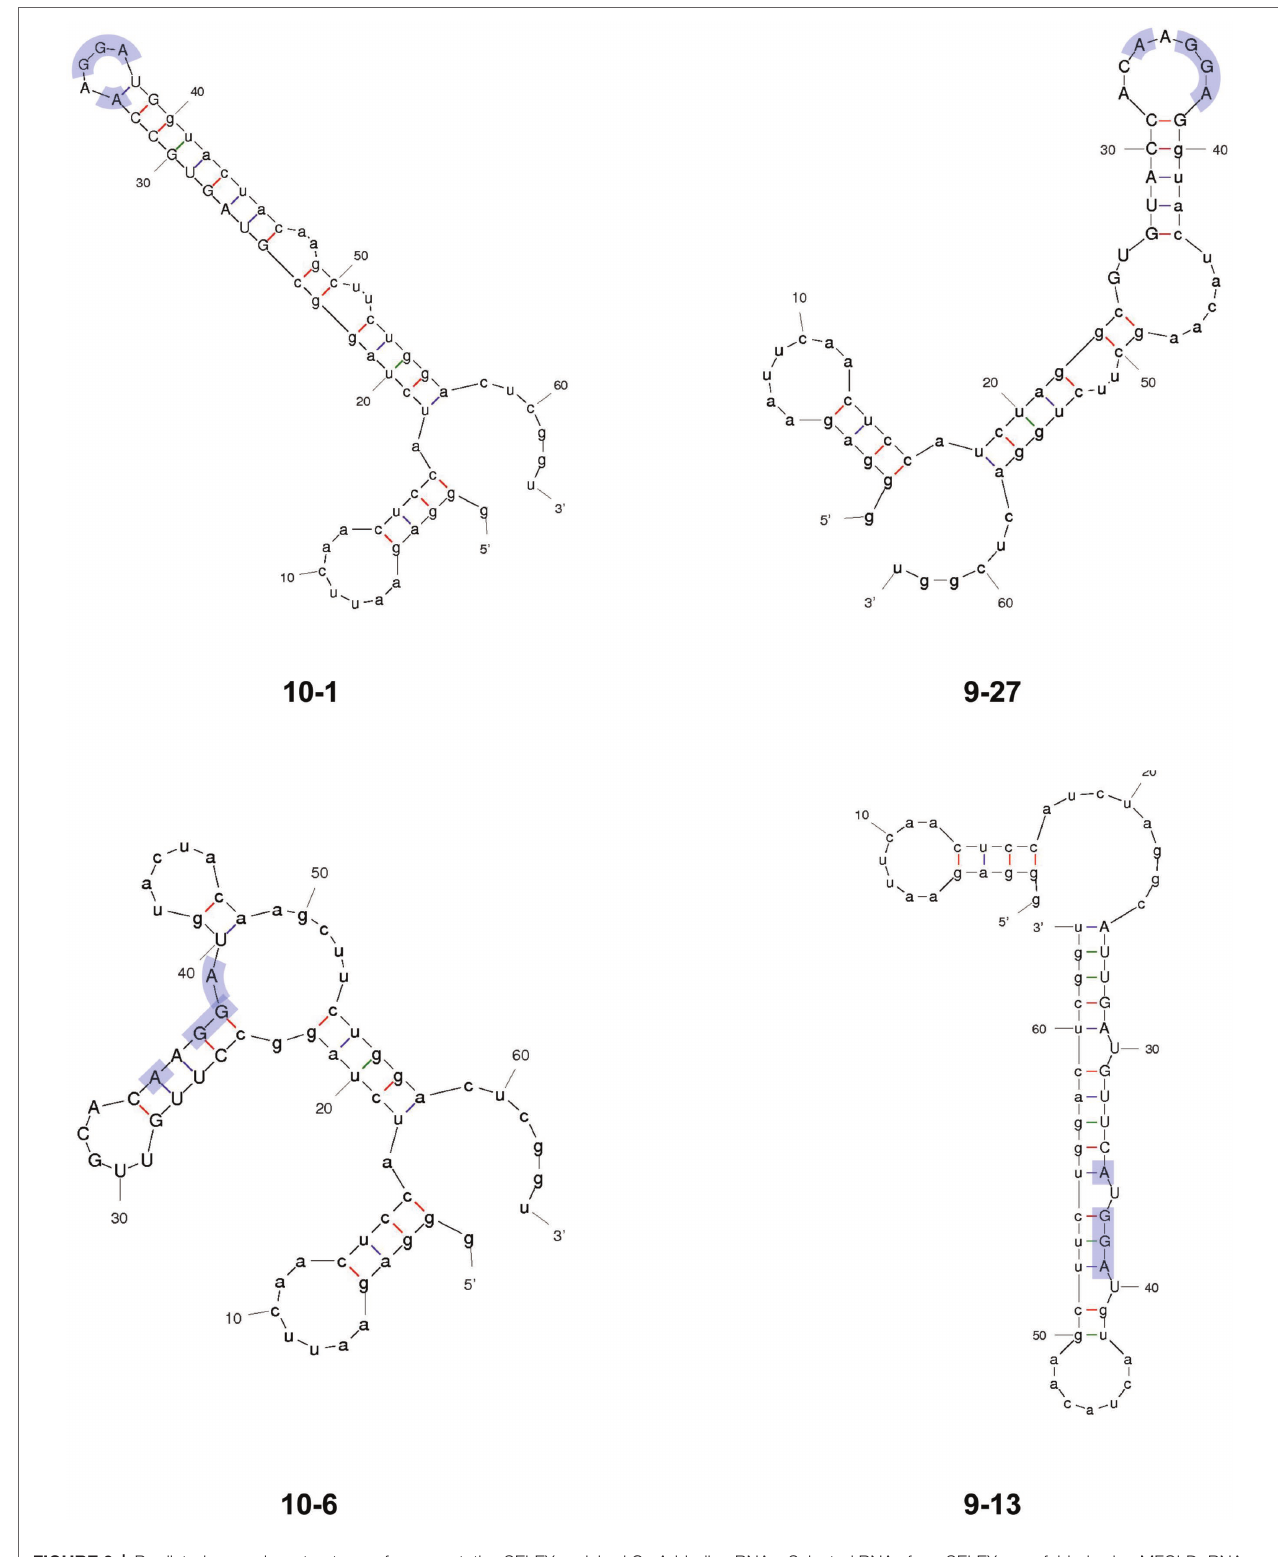
FIGURE 3 | Predicted secondary structures of representative SELEX-enriched CsrA-binding RNAs. Selected RNAs from SELEX were folded using MFOLD. RNAs 10–1 and 9–27 represent the majority of enriched RNAs, in which the AnGGA motif (blue shading) was present at the end of long stem-loops. In RNAs 10–6 and 9–13, the AnGGA motifs were present within the stems